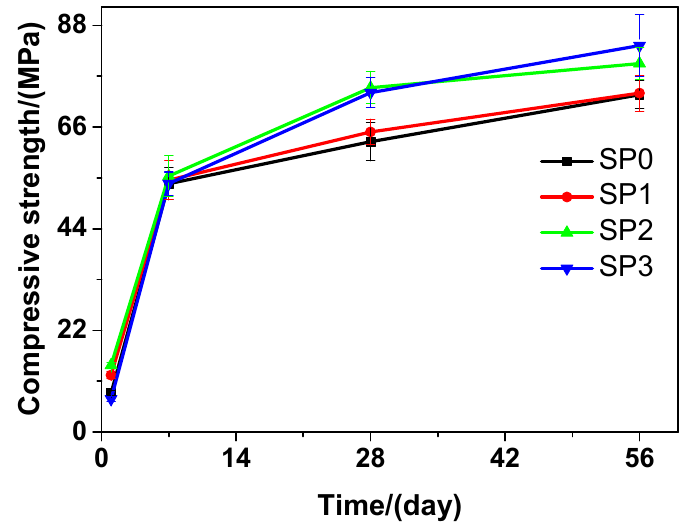
Figure 7. The compressive strength of siliceous sacrificial cement paste at different curing time.